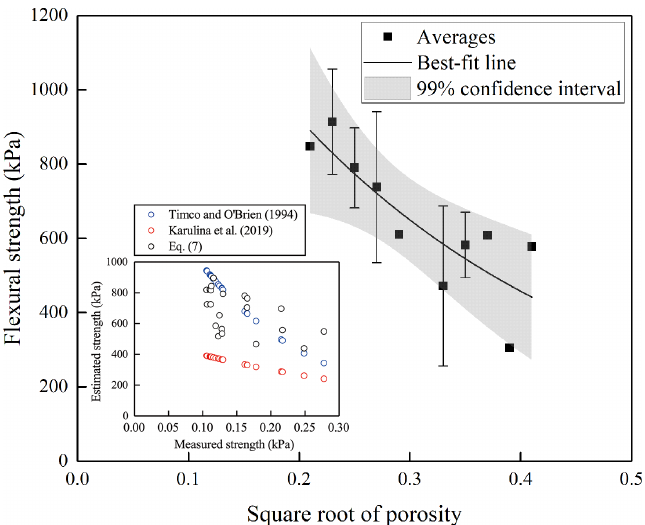
Figure 6. The relationship between average sea ice flexural strength and porosity for congelation ice. The confidence interval is selected based on significance level. The subplot shows the comparisons between estimated flexural strength using the empirical equations in previous studies and this work.